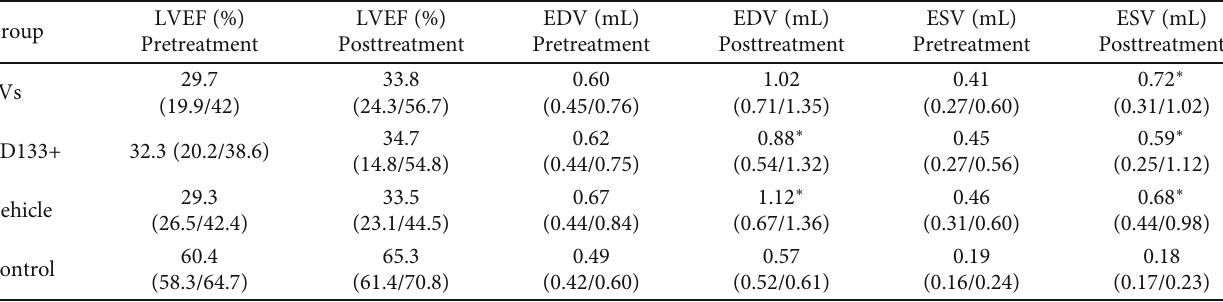
Table 1: Echocardiographic parameters of the left ventricle pre- and